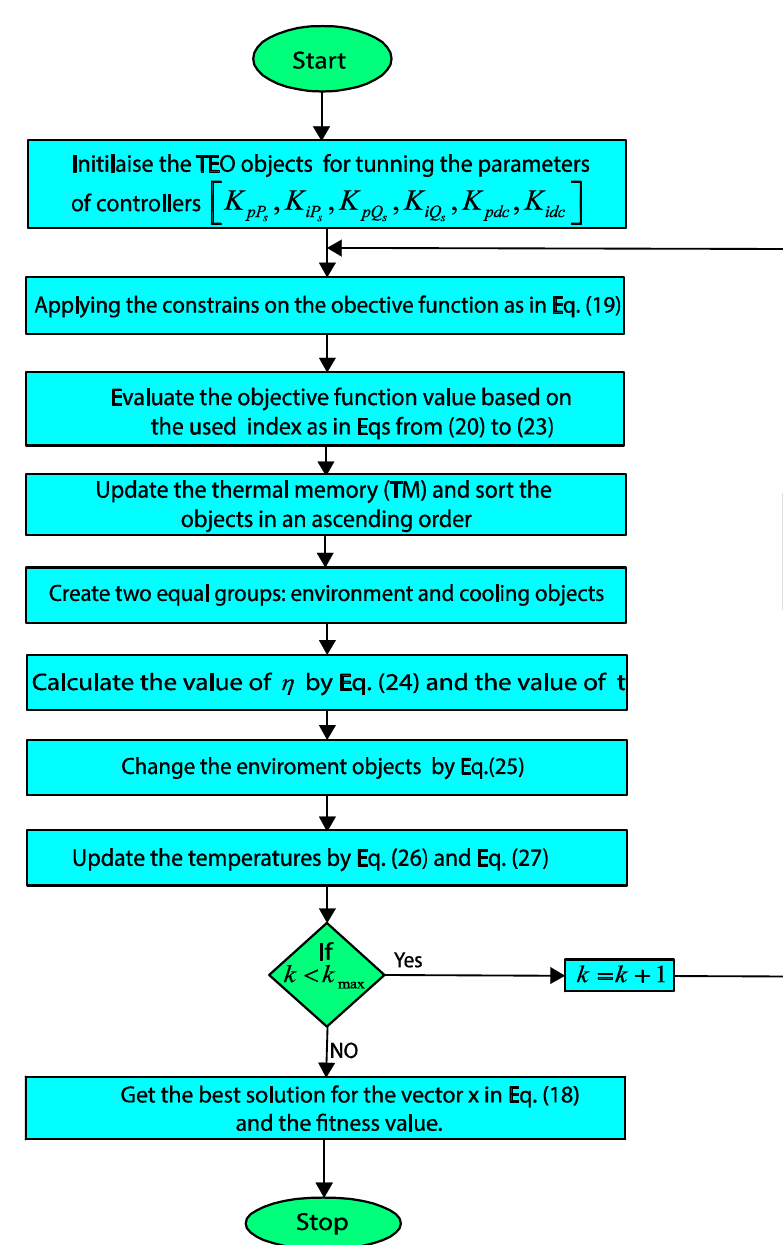
Figure 6. Flowchart of the proposed Thermal Exchange Optimization (TEO)-tuned PI controllers’ Figure 6. parameters.